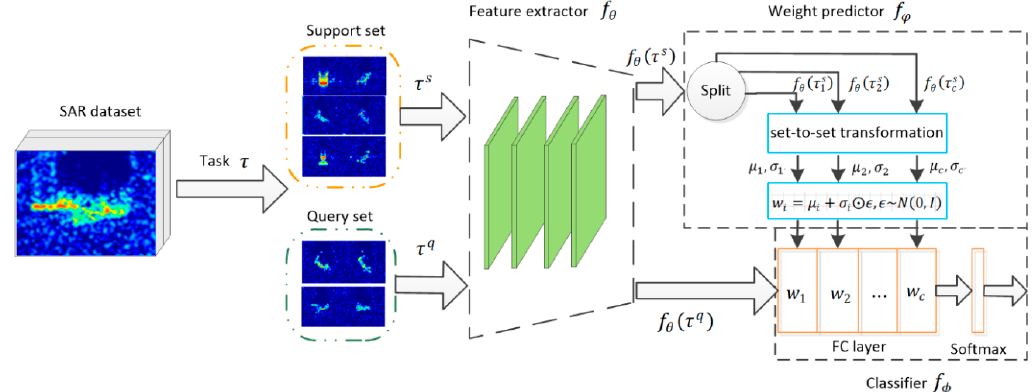
Figure 2. The overall structure of our model. The model samples a task from the synthetic aperture radar (SAR) dataset and divides it into a support set and a query set. The feature extractor uses a four-layer convolutional neural network (CNN) to extract image features. The classifier identifies the category of image features, and its weight is generated by the weight predictor.